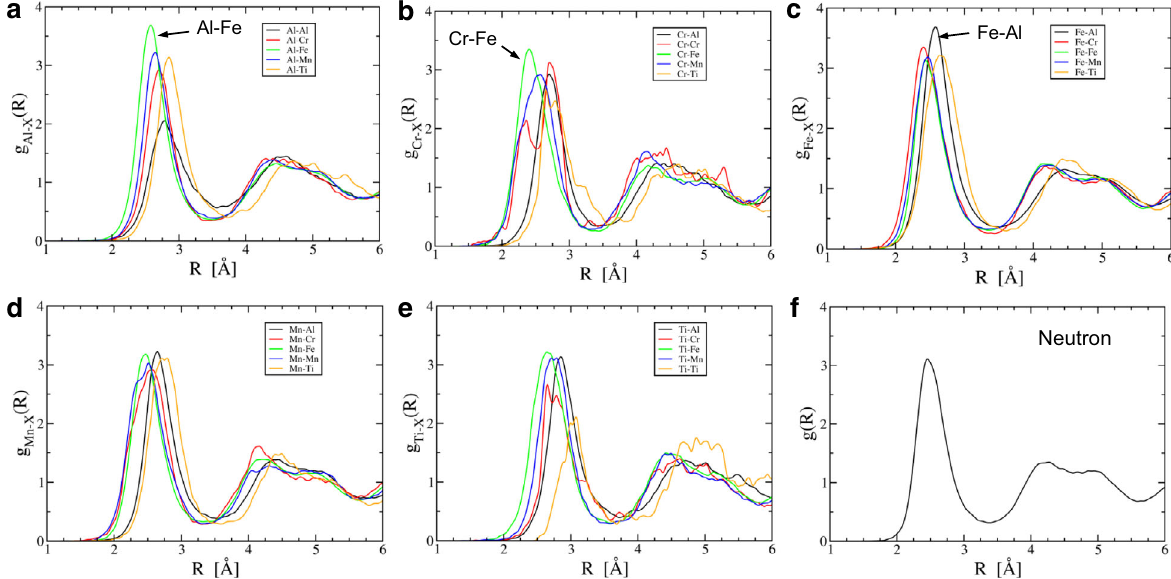
Fig. 5 First-principles calculations on Alloy 1. a – e AIMD-simulated partial PDFs of Alloy 1 (Al 20 Cr 5 Fe 50 Mn 20 Ti 5 ) at T = 1600 °C, and f Neutron- weighted PDF.